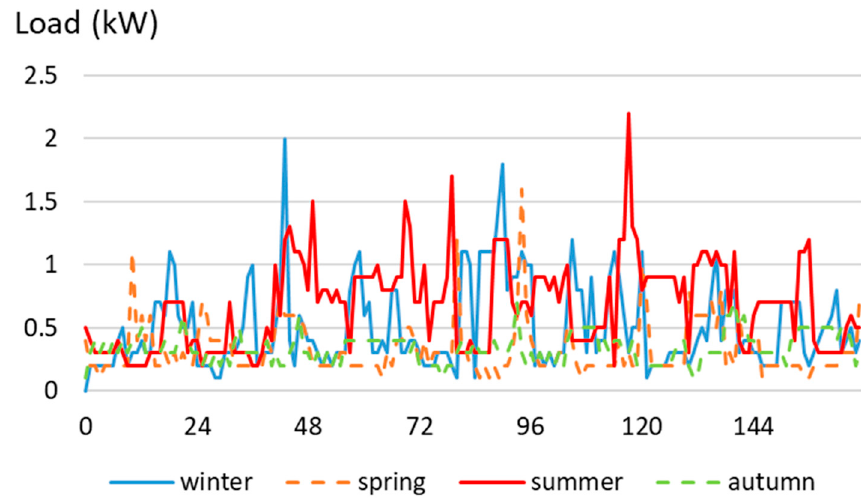
Figure 4. Seasonal variation in domestic load demand.